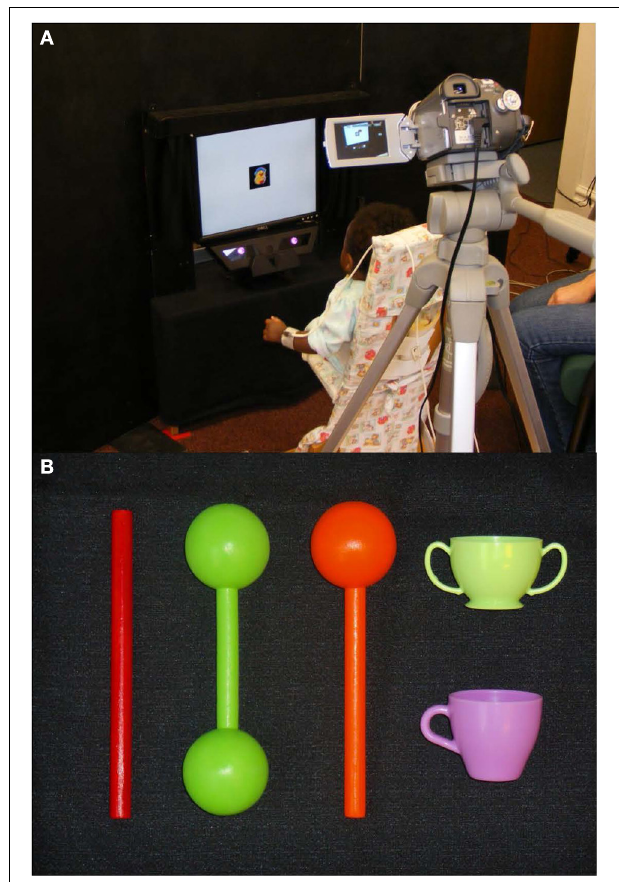
FIGURE 1 | (A) Picture of the experimental setup used to track object-directed looking and reaching in infants and (B) depiction of the five types of objects